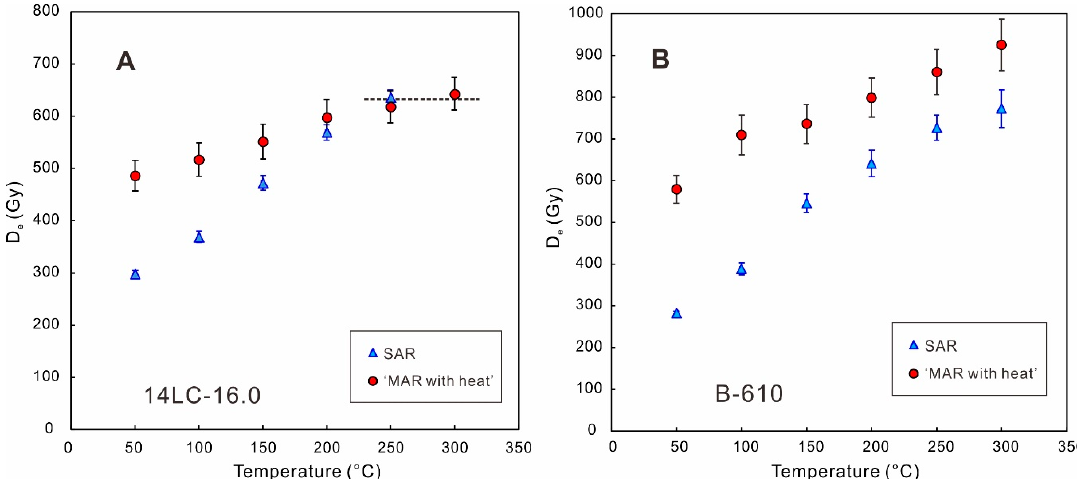
Figure 3. Comparison of D e values obtained by the conventional SAR protocol (Li and Li [63]) and the modified ‘MAR with heat’ protocol (Li et al. [62]), with a six-step IR stimulation from 50 °C to 300 °C. ( A ) Sample 14LC-16.0 is from the base of the L2 layer (second loess layer, MIS 6) in the